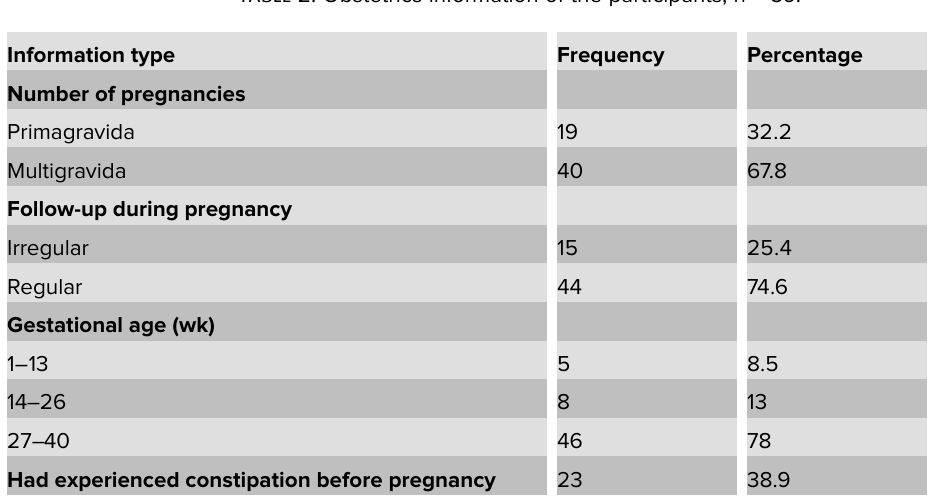
Table 2: Obstetrics information of the participants, n =